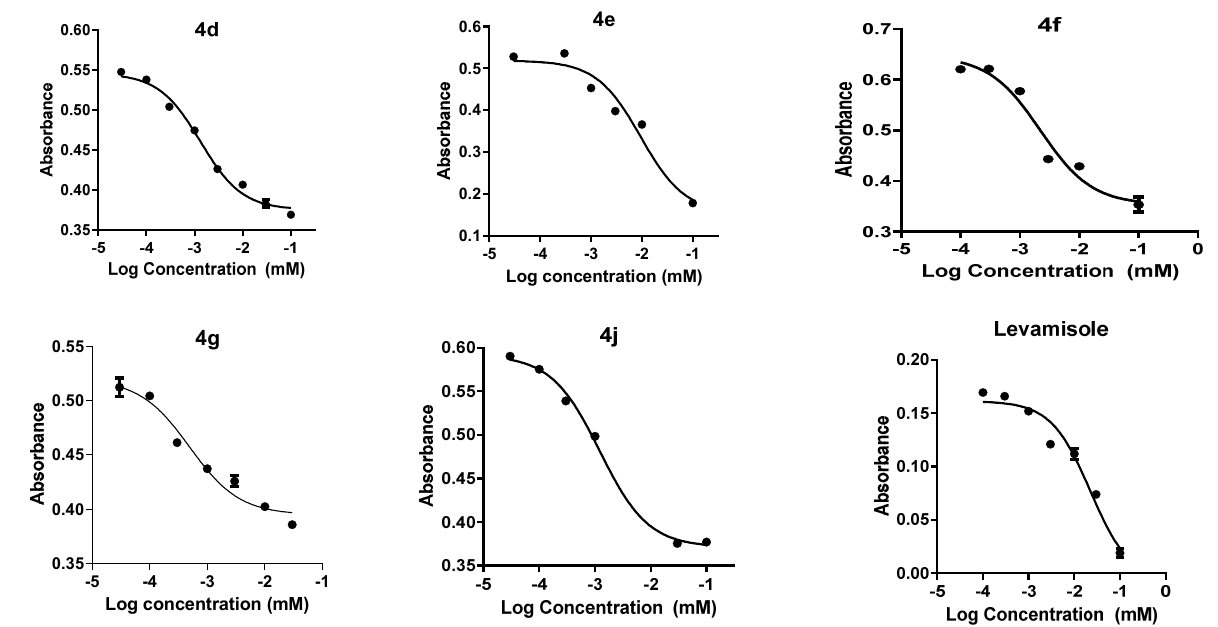
Figure 3. Dose–response curve of some of the most potent inhibitors ( 4d , 4e , 4f , 4g , 4j and Levamisole) of the h ‒ TNAP enzyme.